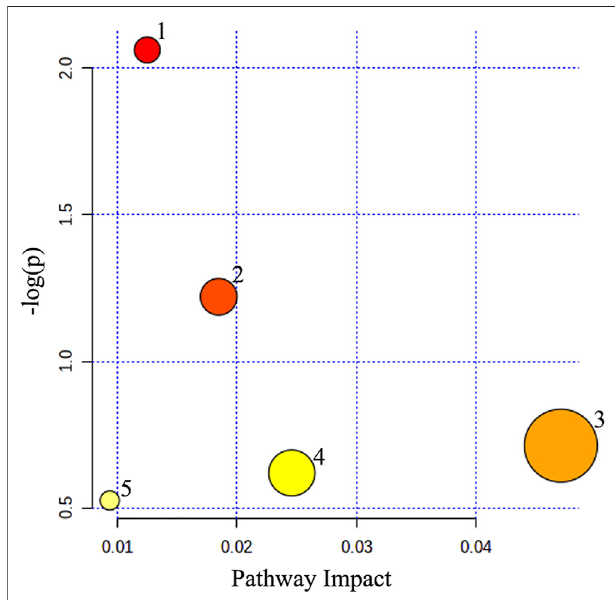
FIGURE 8 | Pathway analyses of differential metabolites in serum sample.